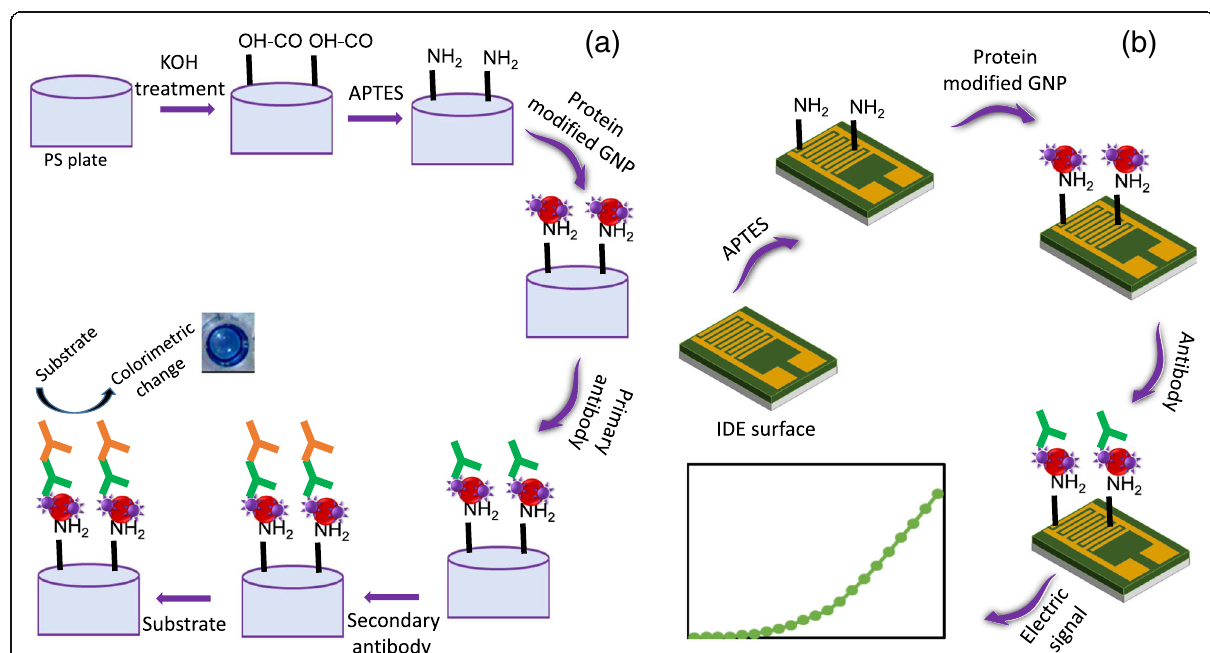
Fig. 1 a Schematic representation of the GNP-assisted ELISA. GNP was premixed with protein and immobilized on APTES-modified ELISA surface. Antibodies were then added. Finally, substrate for HRP was used to detect the target. b Schematic representation of the GNP-assisted